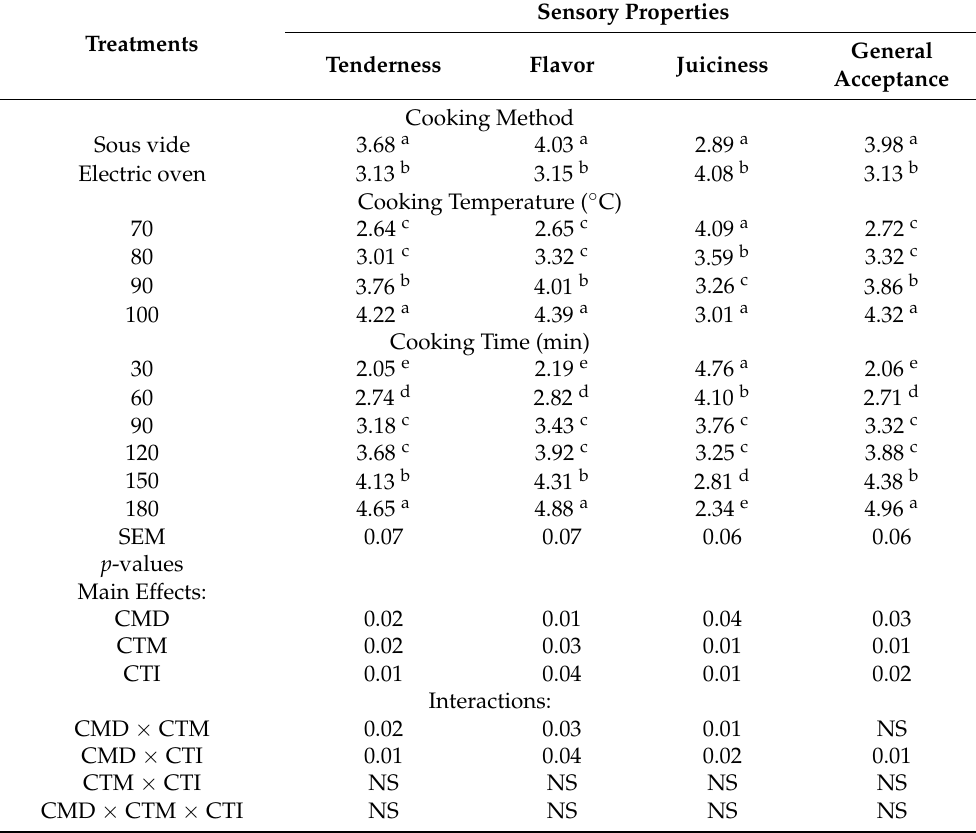
Table 3. Effects of the cooking method (CMD) at different cooking temperatures (CTM) and cooking times (CTI) on the sensory properties of camel meat.